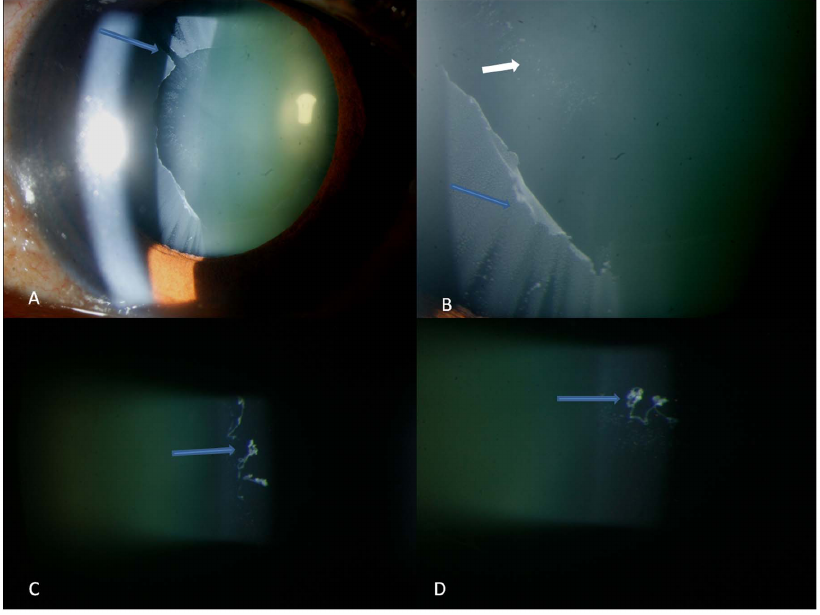
Figure 1. Figures showing additional features of classical pseudoexfoliation like slit shaped empty spaces (arrow in top left), anterior curling of the exfoliation sheet (blue arrow, top right) with pin-point deposits in a wave like pattern anterior to the sheet (small white arrow) which on higher magnification shows globular protrusions at the end of a stalk arising from the edge of the wave (arrows in bottom left and